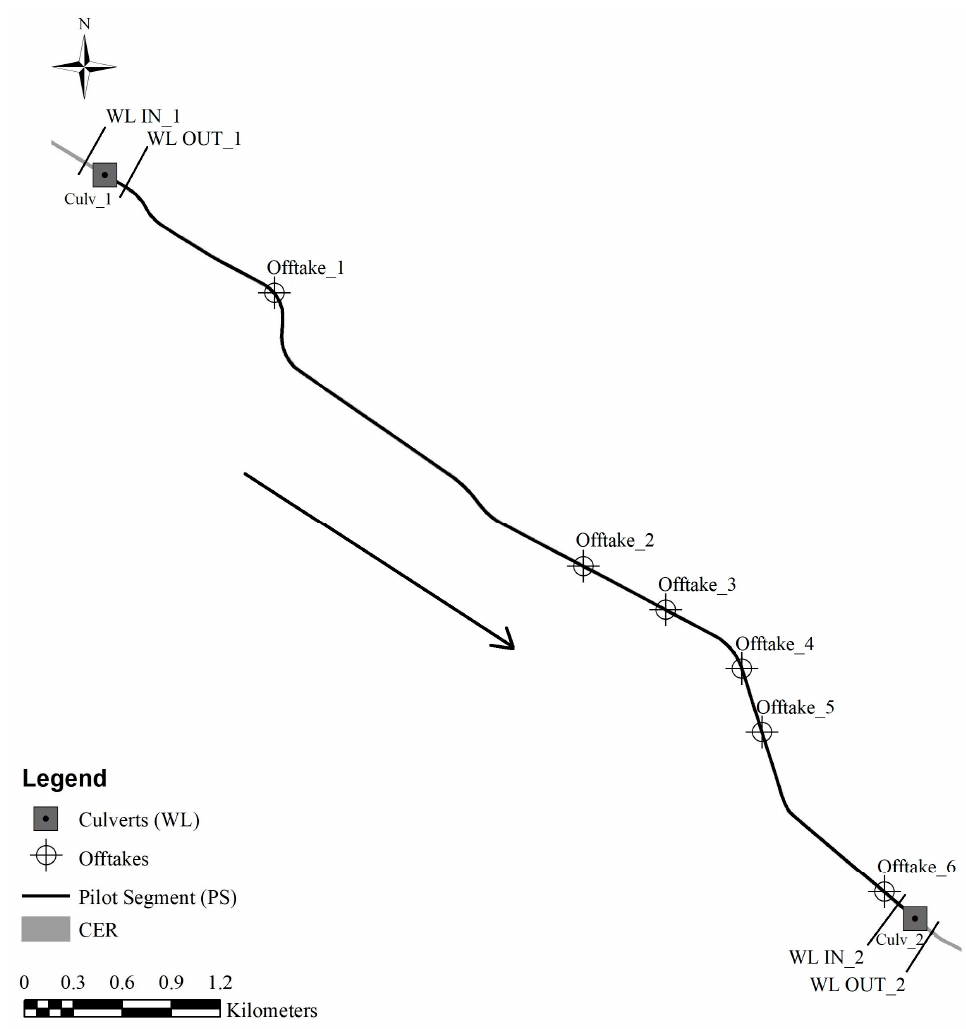
Figure 2. The scheme of Pilot Segment (PS): The six irrigation offtakes, the two culverts passing under the Idice River (Culv_1) and the Quaderna River (Culv_2), the four water gauges (WL) at the IN and OUT of both the culverts.